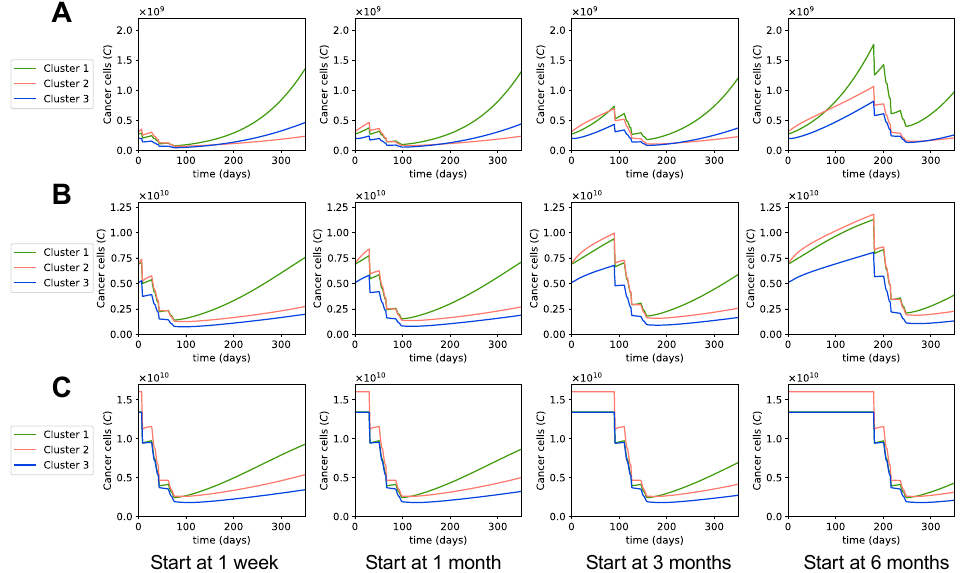
Figure 6. Dynamics with different start times of MAP treatment. Sub-figures ( A – C ) show the dynamics of cancer cell populations for different MAP treatment start times in small, medium, and large tumors, respectively. In each sub-figure, from left to right: the treatment started 1 week, 1 month, 3 months, or 6 months after initial